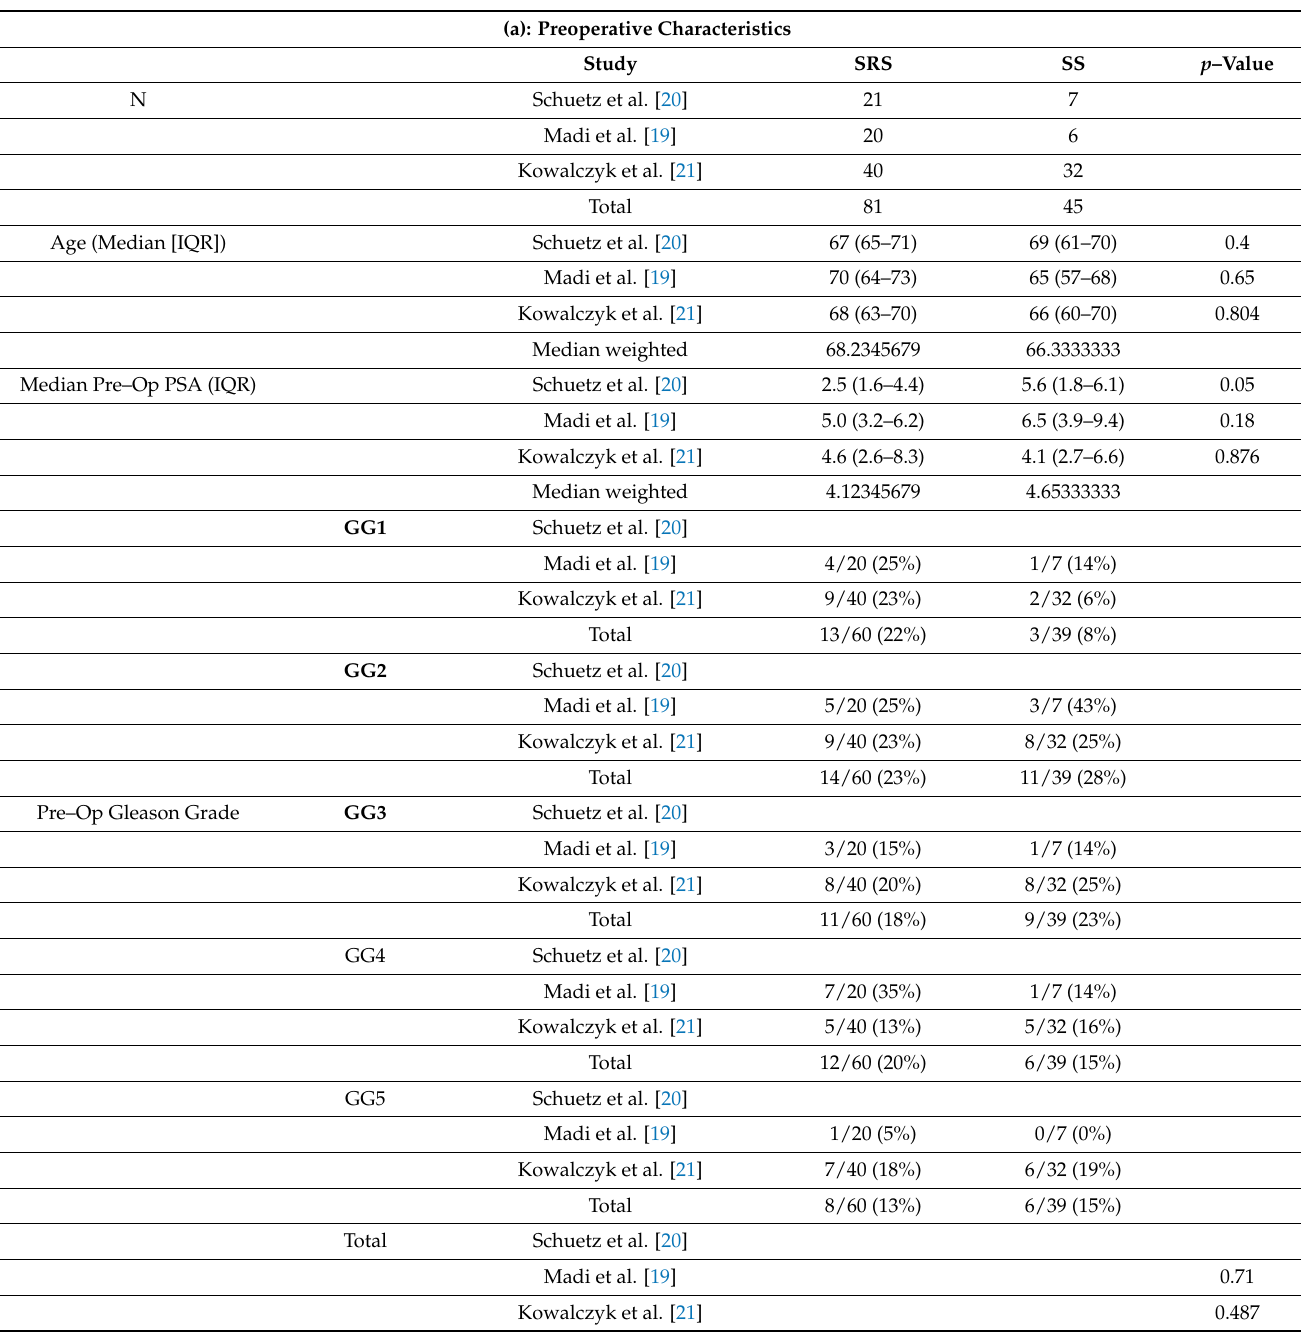
Table 1. (a) Preoperative Characteristics. Total number of patients in each study listed as N. Me- dian age (IQR) was 67 years old and 69 years old in RS-RARP and S-RARP, respectively. Median Preoperative weighted PSA was 4.12 ng/mL in RS-RARP and 4.65 ng/mL in S-RARP. Preoperative Gleason grading is shown with total numbers of the study participants with GG1 22%, GG2 23%, GG3 18%, GG4 20%, and GG5 13% in RS-RARP, and 8%, 28%, 23%, 15%, AND 15% in S-RARP. (b) Patterns of local treatment prior to RP presented with individual studies and total N. In RS-RARP, 21% underwent brachytherapy, 52% underwent EBRT, 1% had SBRT, 20% underwent HIFU, 2% had cryoablation, and 4% with other treatment. In S-RARP, 27% underwent Brachy-therapy, 49% had EBRT, 7% had SBRT, 2% with HIFU, 13% with cryoablation, and 2% with other treatment. There were no significant differences in treatment type in any